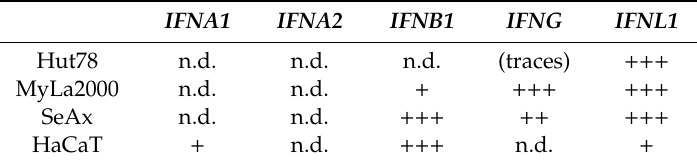
Table 1. 8–Methoxypsoralen and UVA light (8–MOP + UVA) induces interferon (IFN) expressions in cutaneous T-cell lymphoma (CTCL) cell lines and spontaneously immortalized human keratinocytes